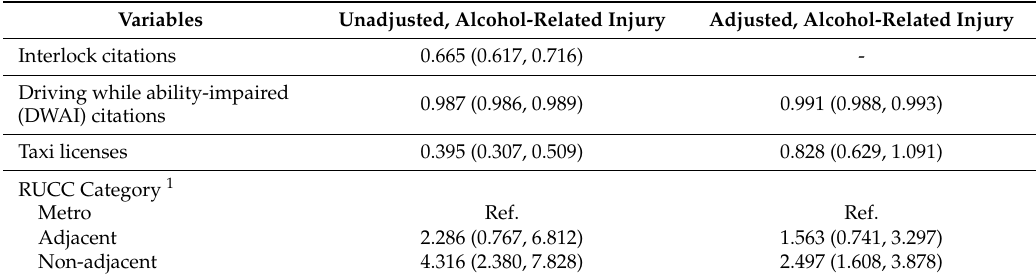
Table 3. Unadjusted and adjusted relative risk (RR) estimates for alcohol-related injury using a zero-truncated negative binomial